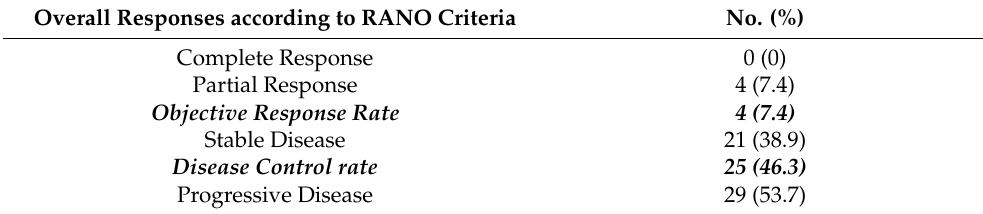
Table 4. Neuro-radiological assessment according to RANO criteria. Bold and Italics: the sum of the prior characteristics.